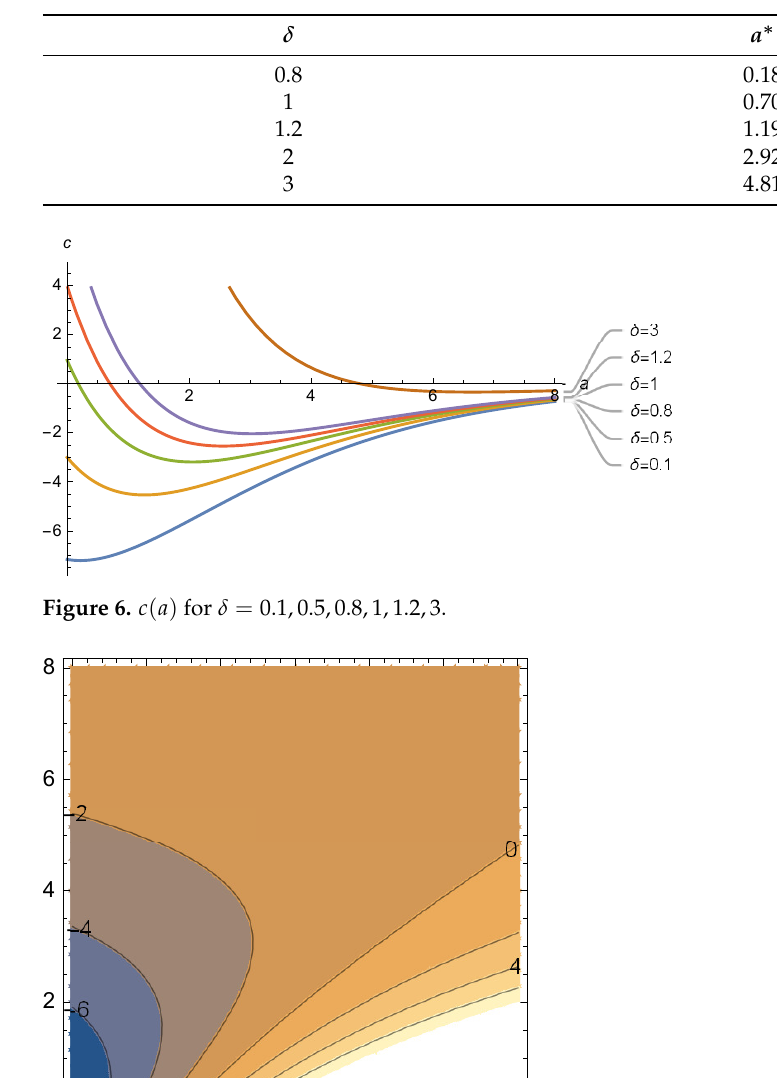
Table 3. a ∗ ( δ ) for different values of δ .